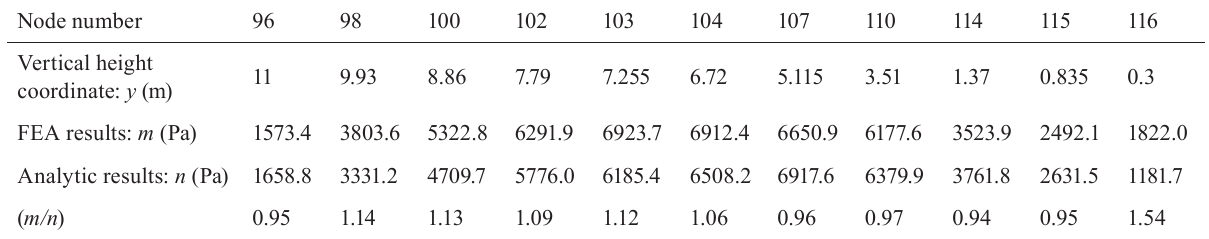
Table 3 Results